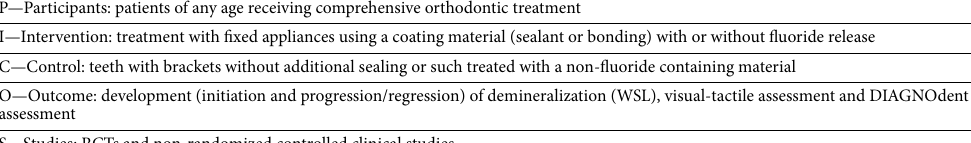
Table 1. PICOS schema: Population (P), Intervention (I), Comparison (C), Outcomes (O) and Study Design